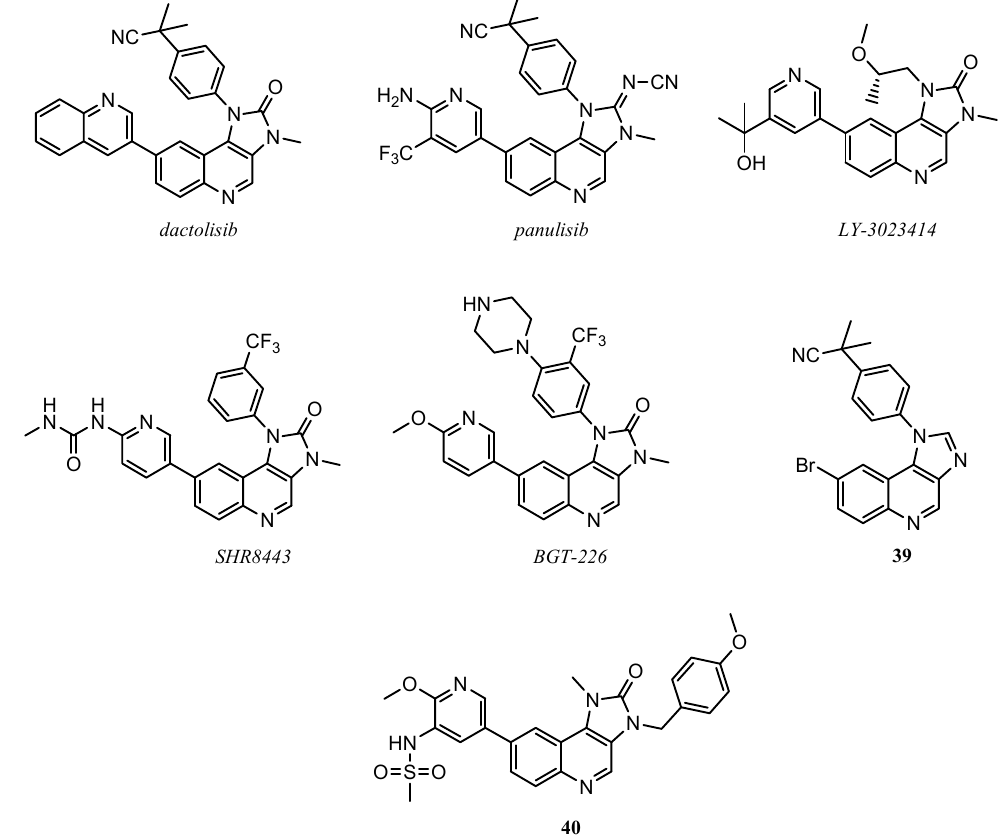
Molecules 2020 , 25 , x FOR PEER REVIEW Figure 13. Imidazo[4,5- c ]quinoline derivatives as promising anticancer PI3K / mTOR inhibitors. Figure 13. Imidazo[4,5- c ]quinoline derivatives as promising anticancer PI3K/mTOR inhibitors.